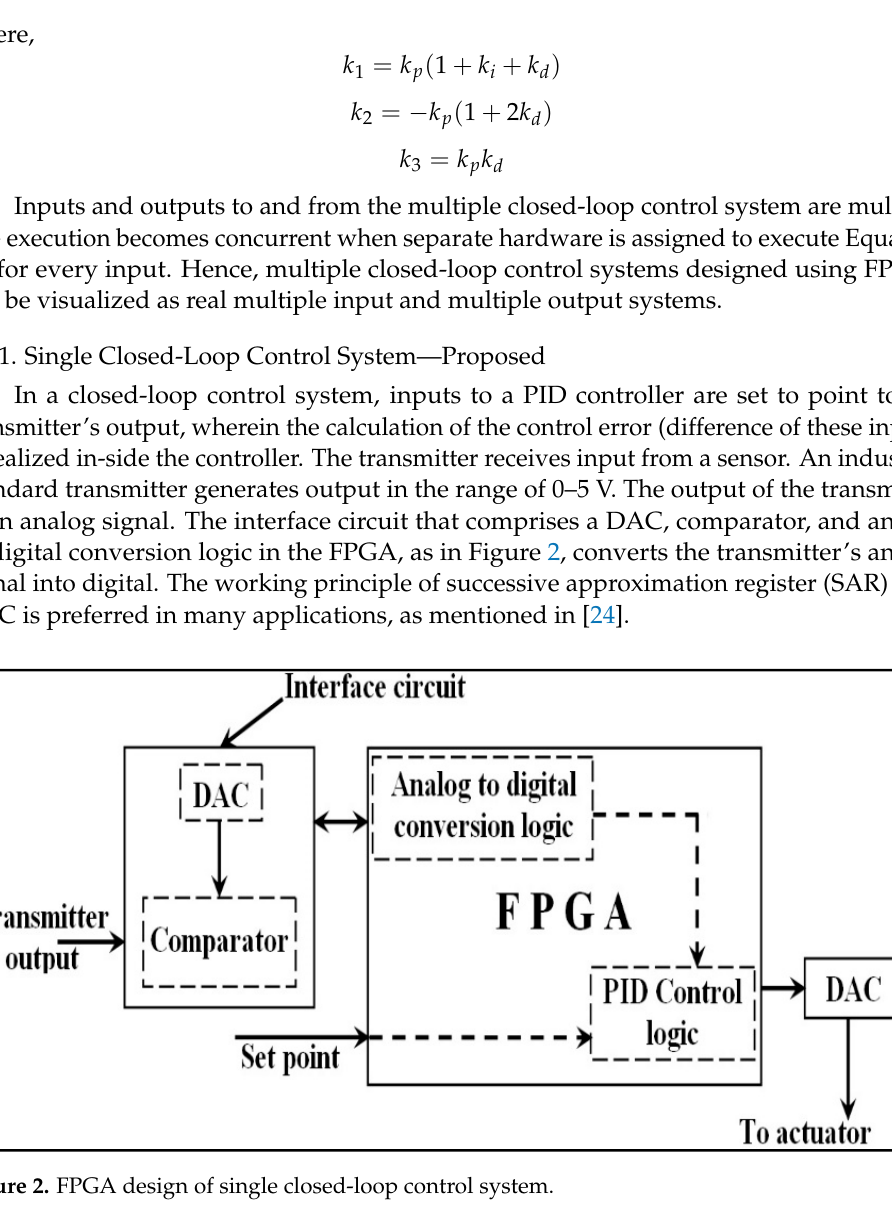
Figure 3. FPGA design of analog input module for a single channel. It functions on the working principle of successive approximation register (SAR) type ADC. The most significant bit (MSB) of the SAR register will be set, and the remaining bits will be in reset condition. A register in an FPGA is declared as a SAR register. The